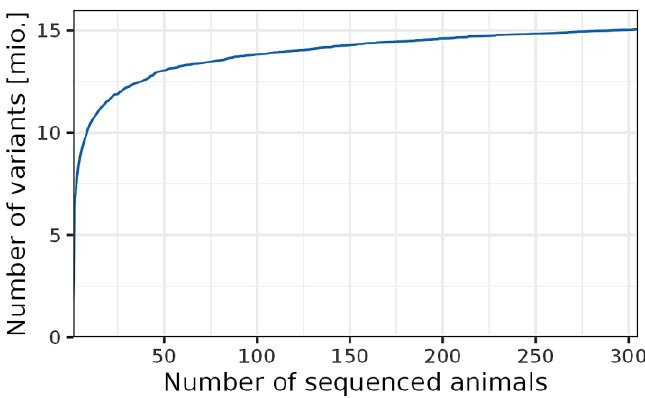
Figure 1. Number of identified variants per number of sequenced animals.